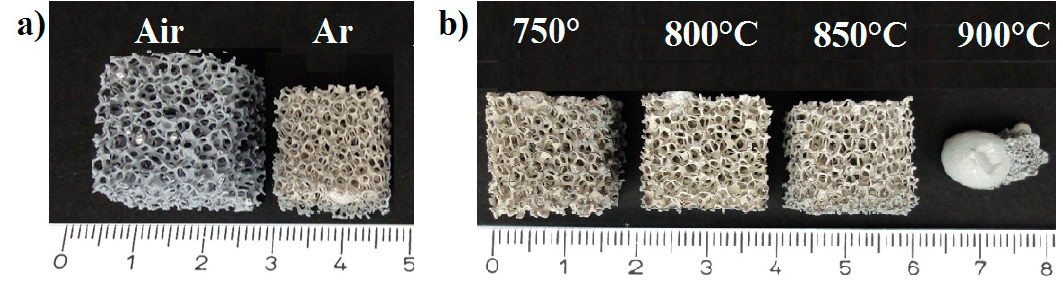
Figure 3. Al foams after thermal processing for 3 h in air and Ar at 750 ◦ C ( a ) and Ar at 750–900 ◦ C ( b ).